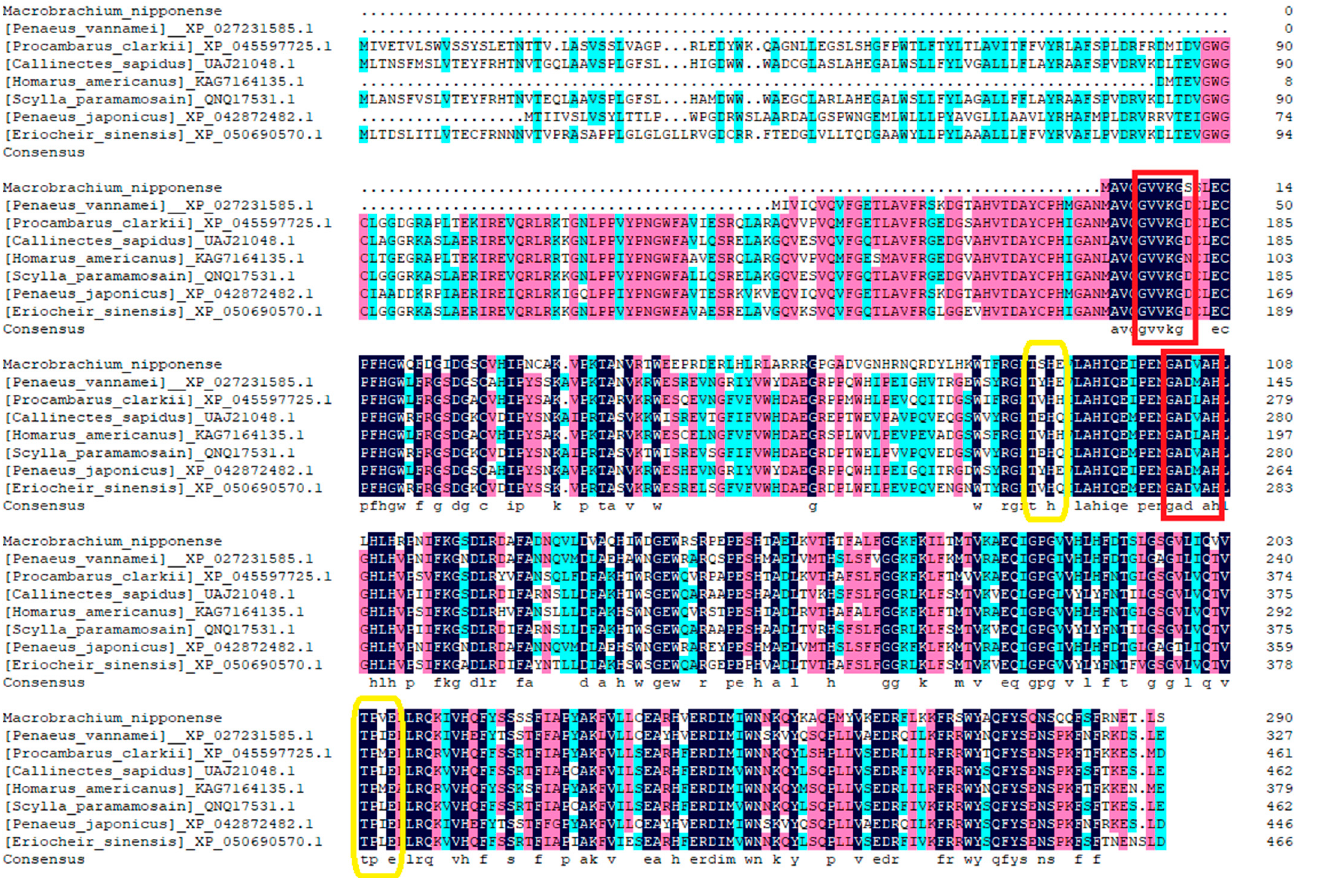
Figure 2. Alignment of the deduced amino acid sequence of Mn-CH7D with other species. N- myristoylation sites are marked by red boxes, and Casein kinase II phosphorylation sites are marked by yellow boxes.